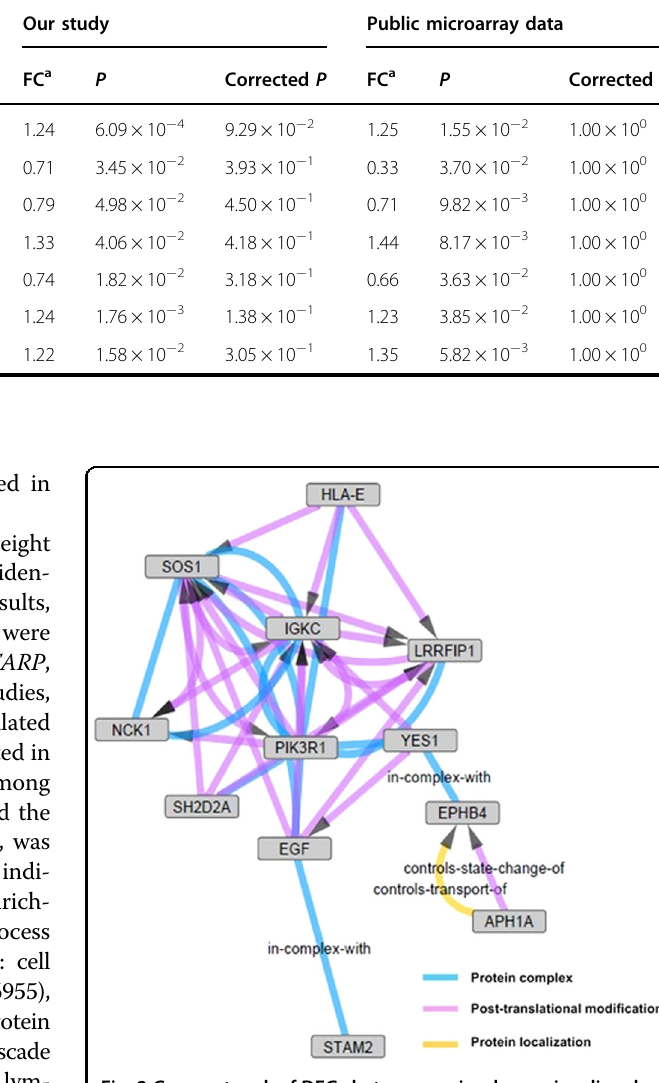
Fig. 2 Gene network of DEGs between major depressive disorder patients and healthy controls. Twelve genes related to signal transduction and the immune system are involved in this network with an uncorrected p -value < 0.05. APH1A , aph-1 homolog A, gamma secretase subunit; EGF , epidermal growth factor; EPHB4 , EPH receptor B4; HLA-E , major histocompatibility complex class I E; IGKC